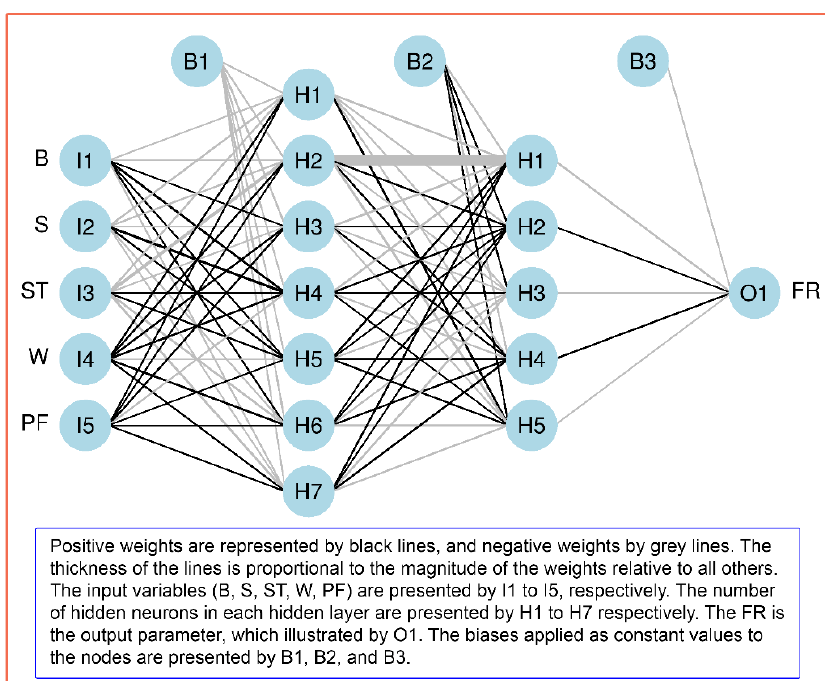
Figure 6. The ANN 5-7-5-1 model for estimating FR.